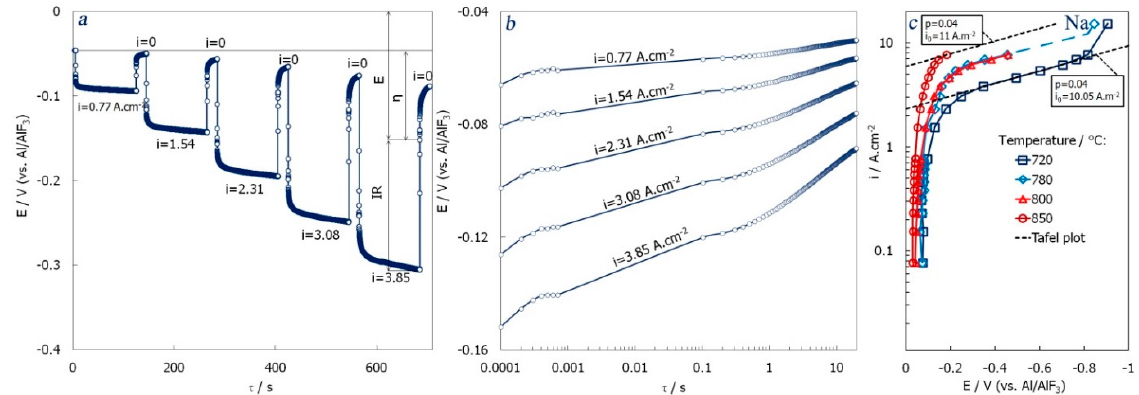
Figure 3. Results obtained in the single-capillary cell with the NaCl–KCl (1:1 molar ratio) + 10 wt.% AlF 3 melt: ( a )—typical potential vs. time dependence obtained at 800 °C, ( b )—potential relaxation during 20 s current interrupt, ( c )—stationary galvanostatic polarization curves obtained at 720–850 °C.